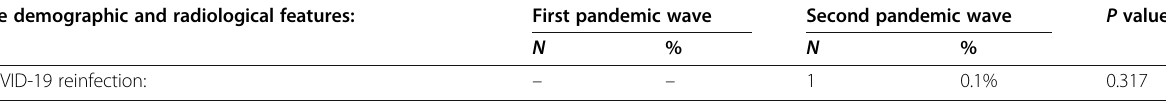
Table 1 Distribution of COVID-19 patients according to the demographic and radiological features in comparison between the first and second pandemic waves with statistical significance (Continued) The demographic and radiological features: